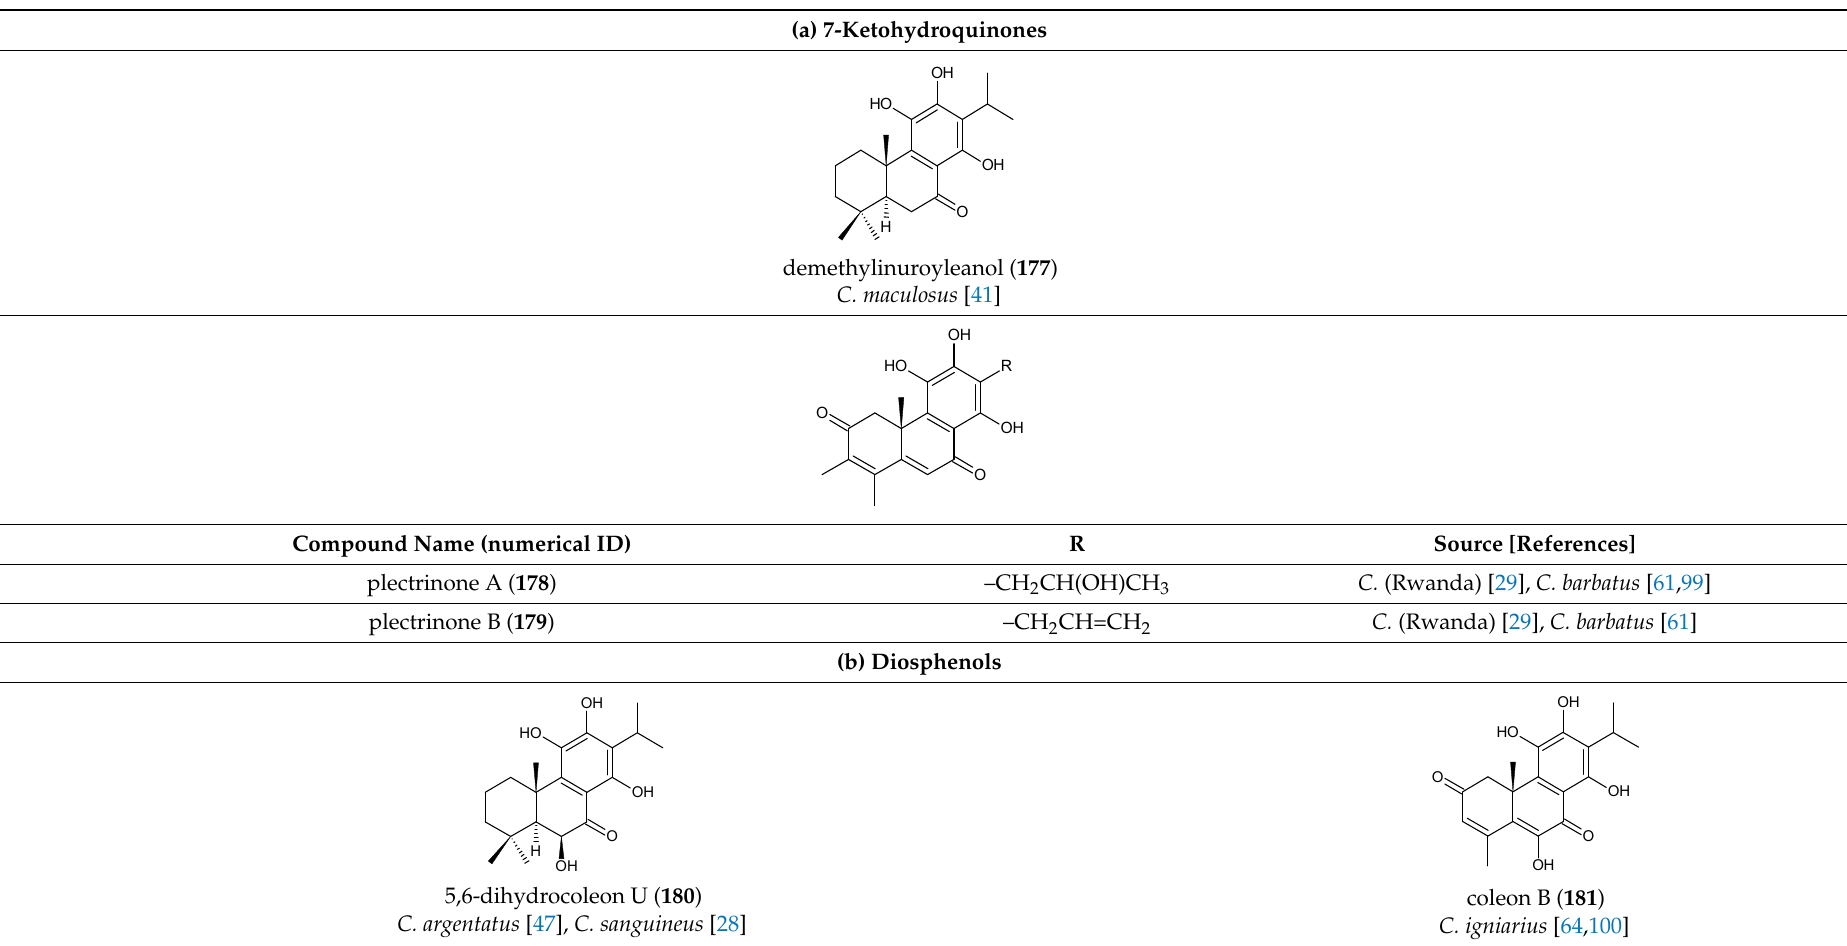
Table 7. Hydroquinones of the genus Plectranthus s.l.